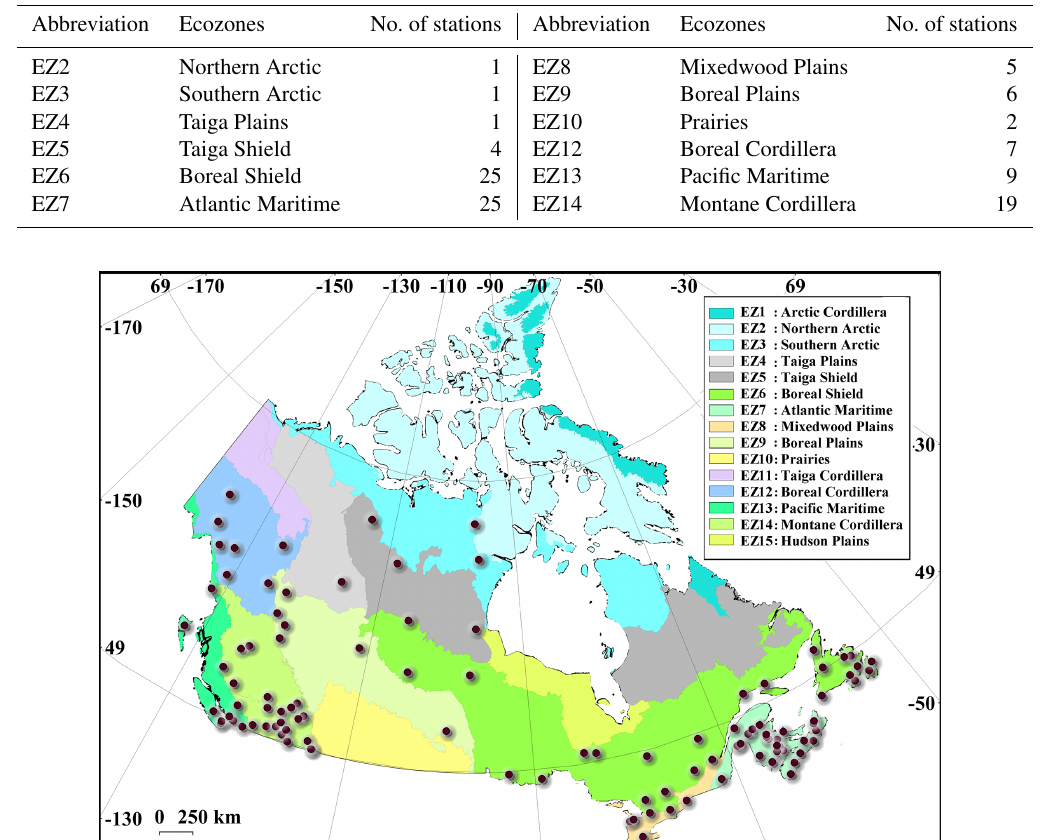
Table 2. List of Canadian ecozones with at least one RHBN station in this study, along with their abbreviations and the number of RHBN stations considered within each ecozone.